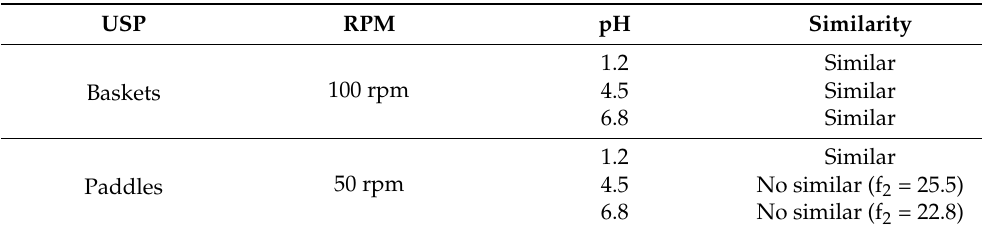
Table 4. Similarity results obtained from the different dissolution experiments for the reference product and the test product.